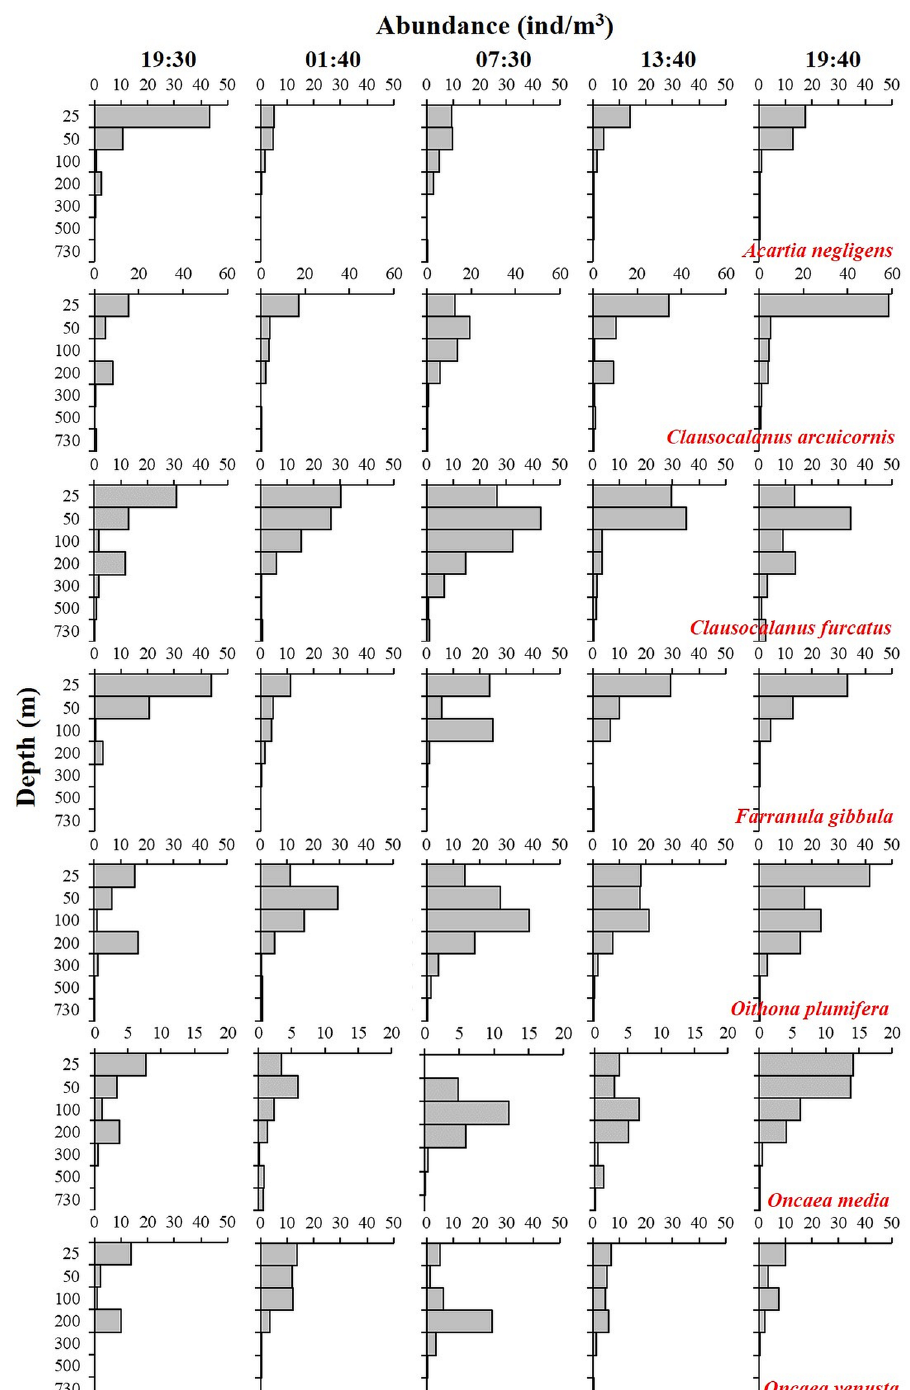
Figure 4. Diel vertical distribution in numerical abundance (ind/m 3 ) of the dominant zooplankton species in the Caroline Seamount area on June 2 to 3,